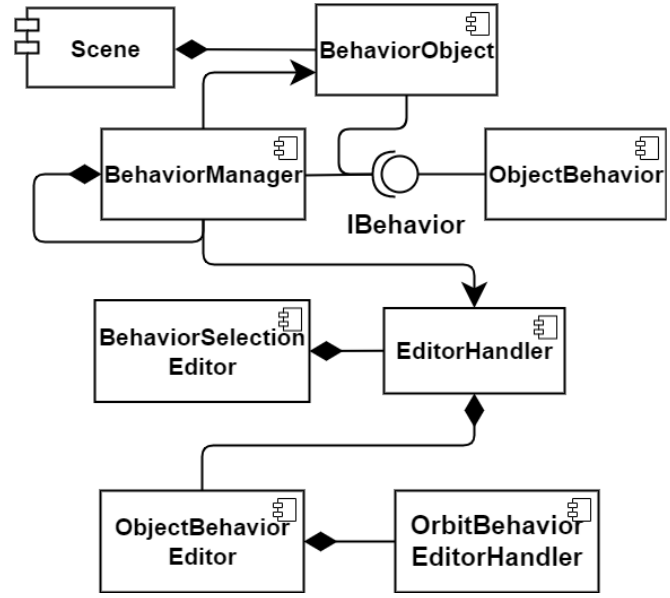
Figure 6. Object movement behavior tool’s components.